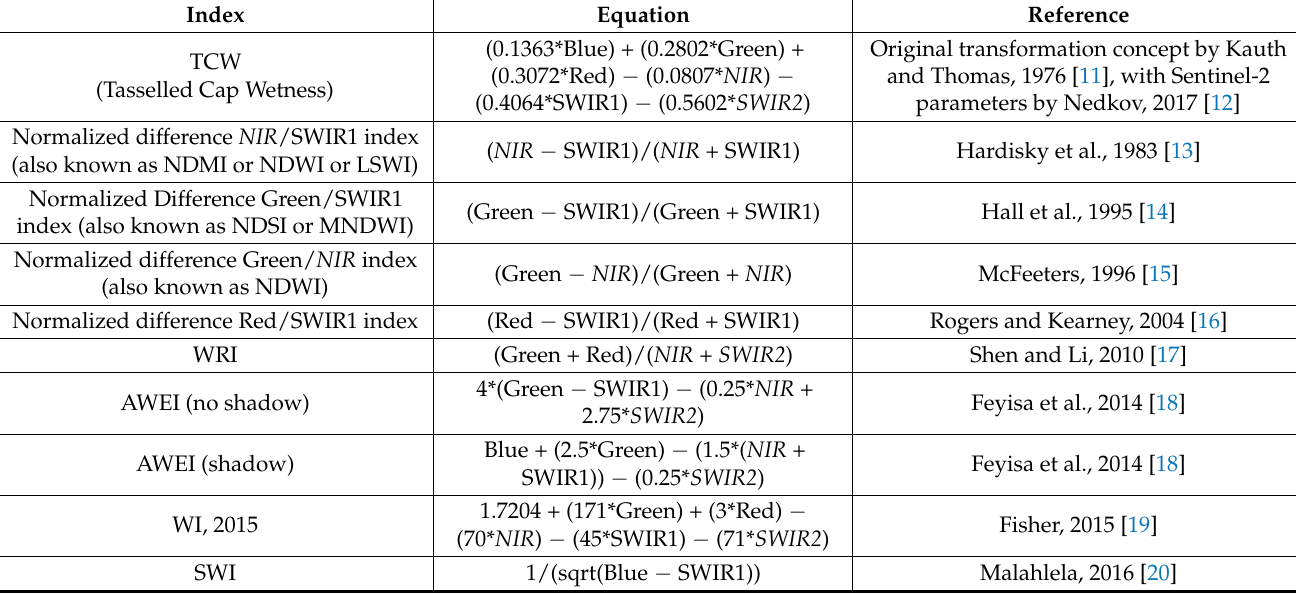
Table 1. Major water indices applied to imagery from Landsat and Sentinel-2 satellites. References are provided by first use, regardless of thematic